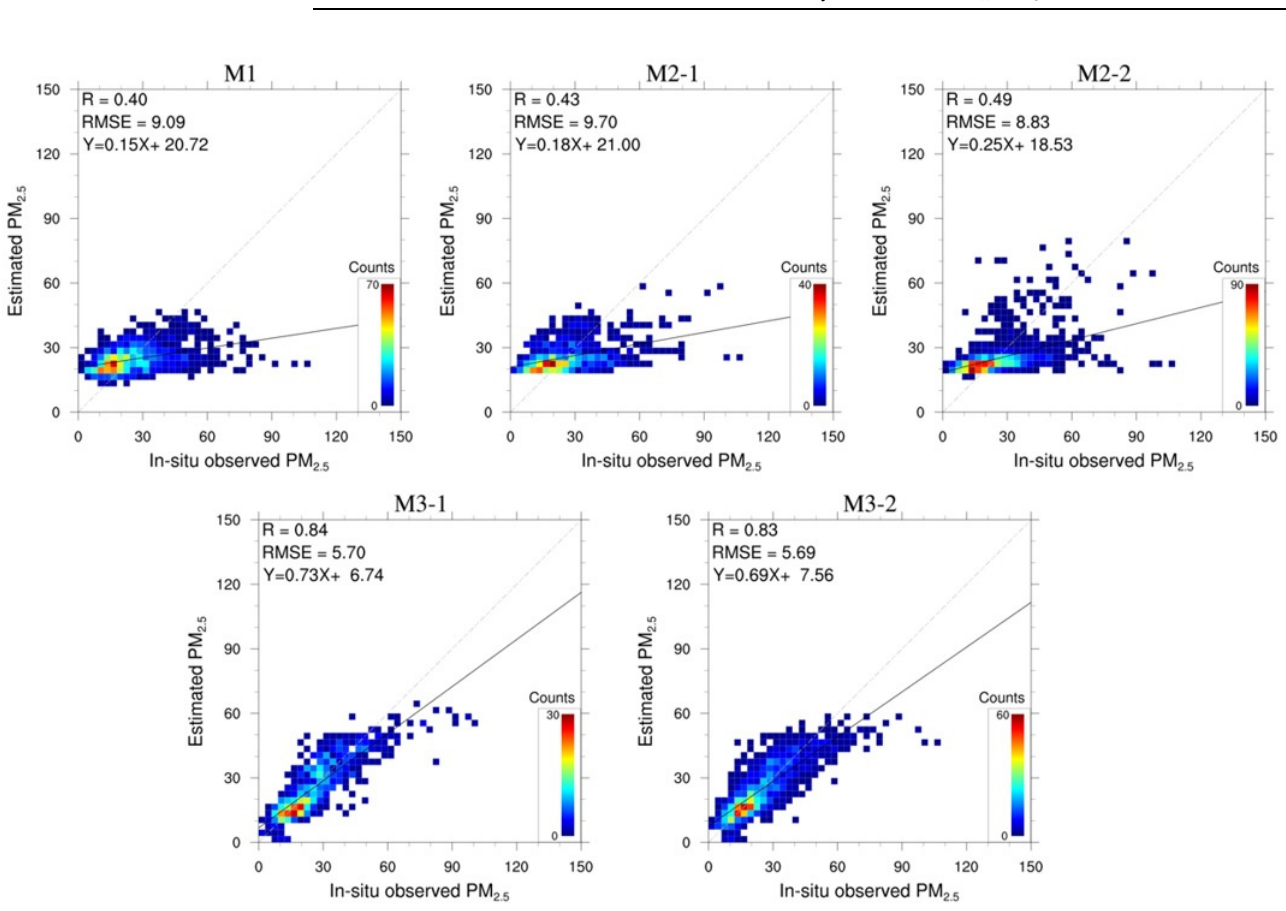
Figure 1. Comparison between in situ observed and estimated PM 2.5 (unit: µ g/m 3 ) using MODIS-DT AOD values based on 5 statistical models in this study (M1, M2-1, M2-2, M3-1, and M3-2). Colors indicate the occurrence of each case. The dashed line is the 1:1 line and the solid line shows the linear regression pattern.